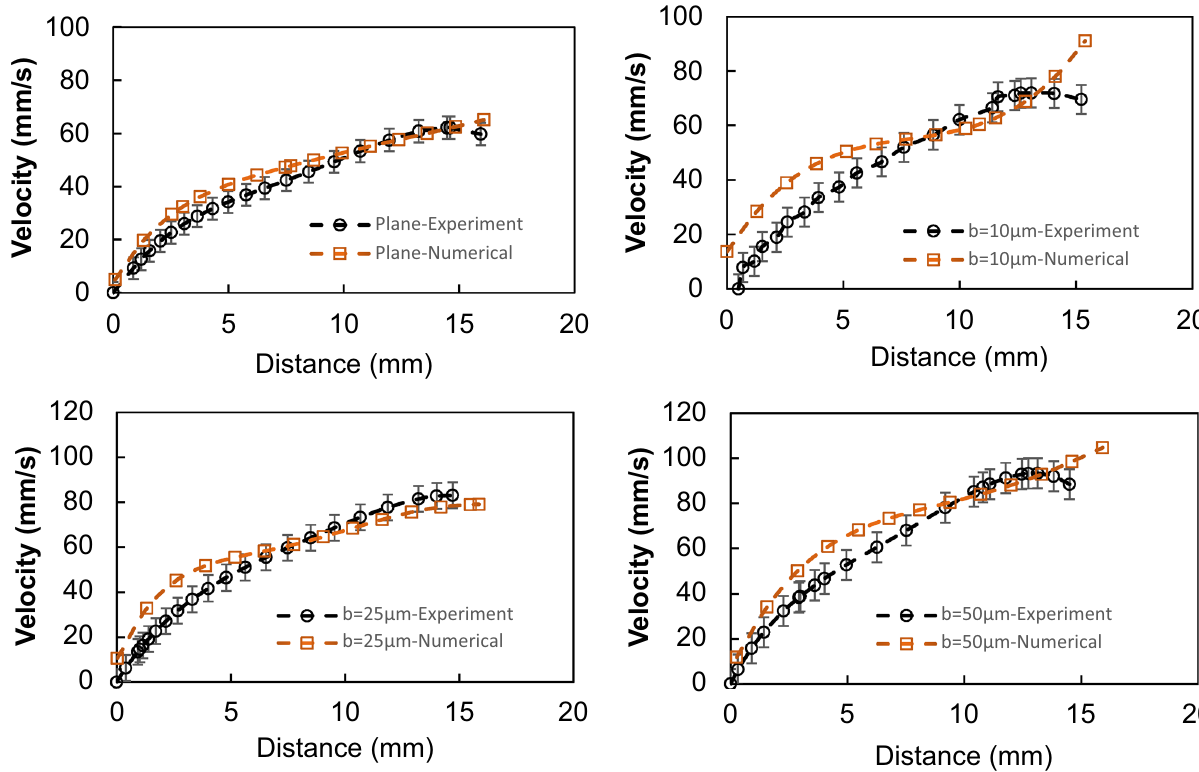
Figure 7. Droplet translational velocity obtained from experiment and simulations for various micro-post gap scrapings. for 40 µL droplet, δ = 5°. Droplet volume is 40 µL, the inclination angle is δ = 5°.